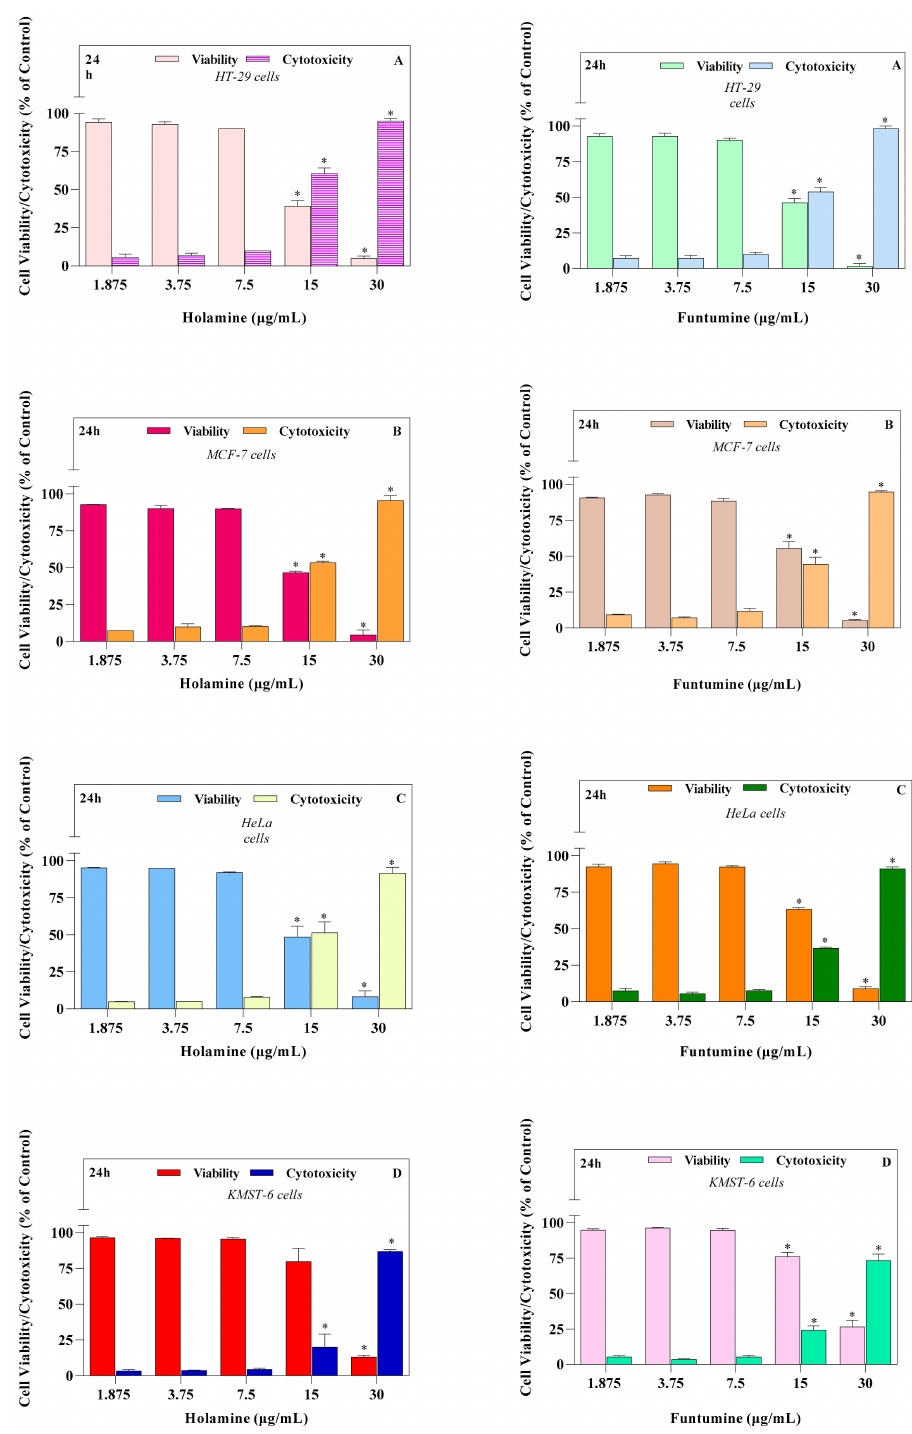
Figure 2. The cytotoxic e ff ects of increasing concentrations of holamine and funtumine in ( A ) HT-29, ( B ) MCF-7, ( C ) HeLa, and ( D ) KMST-6 cells following a 24-h exposure, as evaluated by the CytoTox-Glo ™ assay. Each bar represents the mean ± SEM of duplicate experiments. The * indicates statistical significance at p < 0.05 between the treatments analyzed—i.e., for viability assays in HT-29 cells, the e ff ect elicited by 30 µ g / mL of holamine di ff ered significantly from those of the 1.875, 3.75, 7.5 and 15 µ g / mL treatments. However, in the case of cytotoxicity, the e ff ects elicited by 15 and 30 µ g / mL of holamine di ff ered significantly from those of the 1.875, 3.75 and 7.5 µ g / mL treatments. The same statistical analogy holds for the other cell